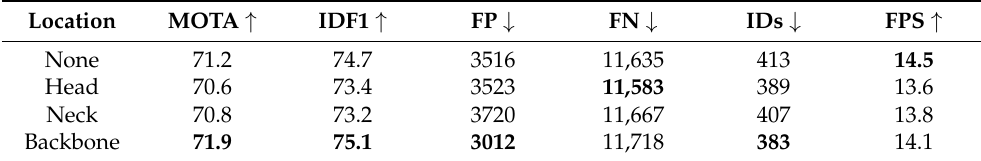
Table 2. Comparison of the coordinate attention module (CAM) at different locations for the encoder– decoder network. Here, ↑ means higher is better, and ↓ means lower is better.The best results are shown in bold .